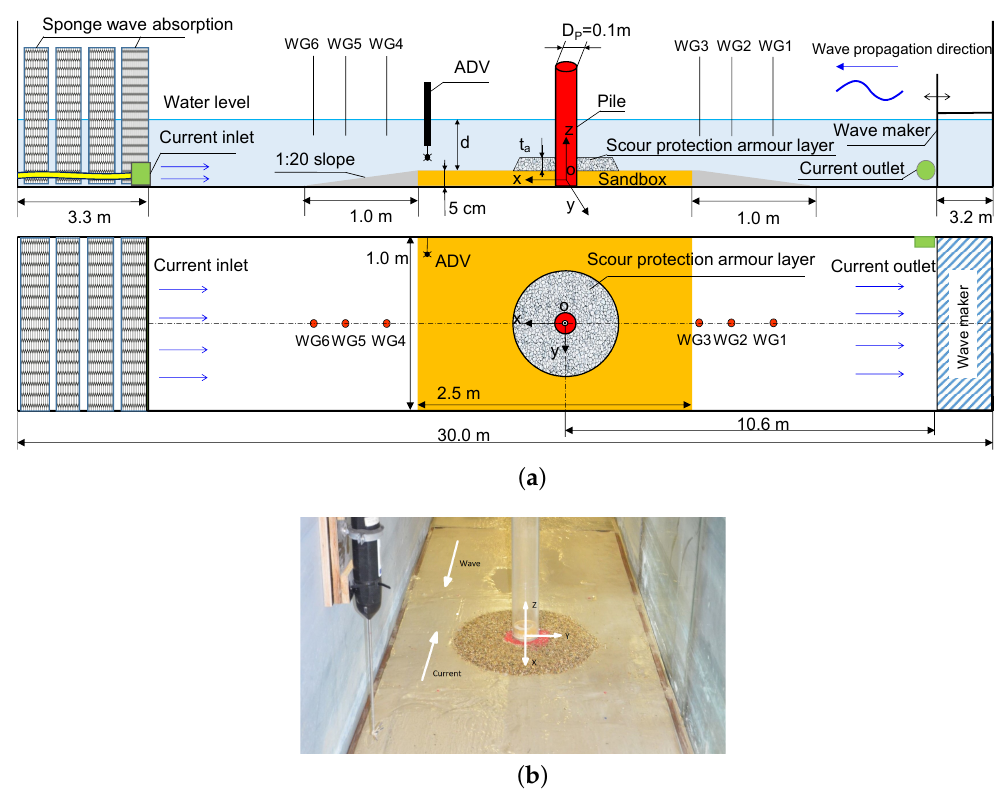
Figure 1. Scour protection model around a scale model of a single OWT monopile: ( a ) Sketch of the layout of wave flume experimental setup (not to scale); ( b ) Illustration of the model installed in the UGent wave